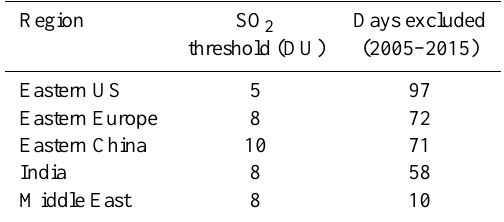
Table A1. OMI PBL SO 2 regional thresholds for filtering transient volcanic clouds and number of days excluded. The volcanic filter is also applied to the OMI NO 2